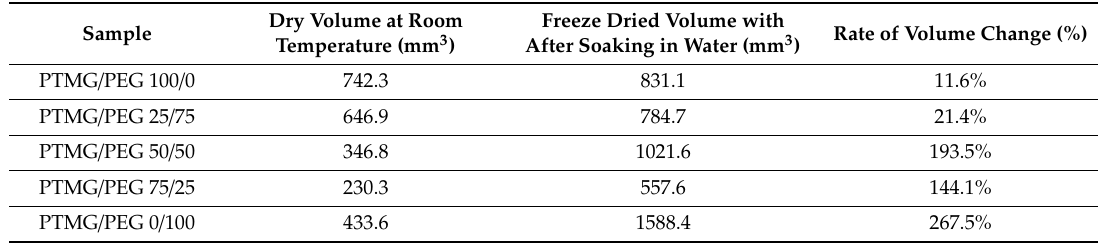
Table 2. Volume change before and after